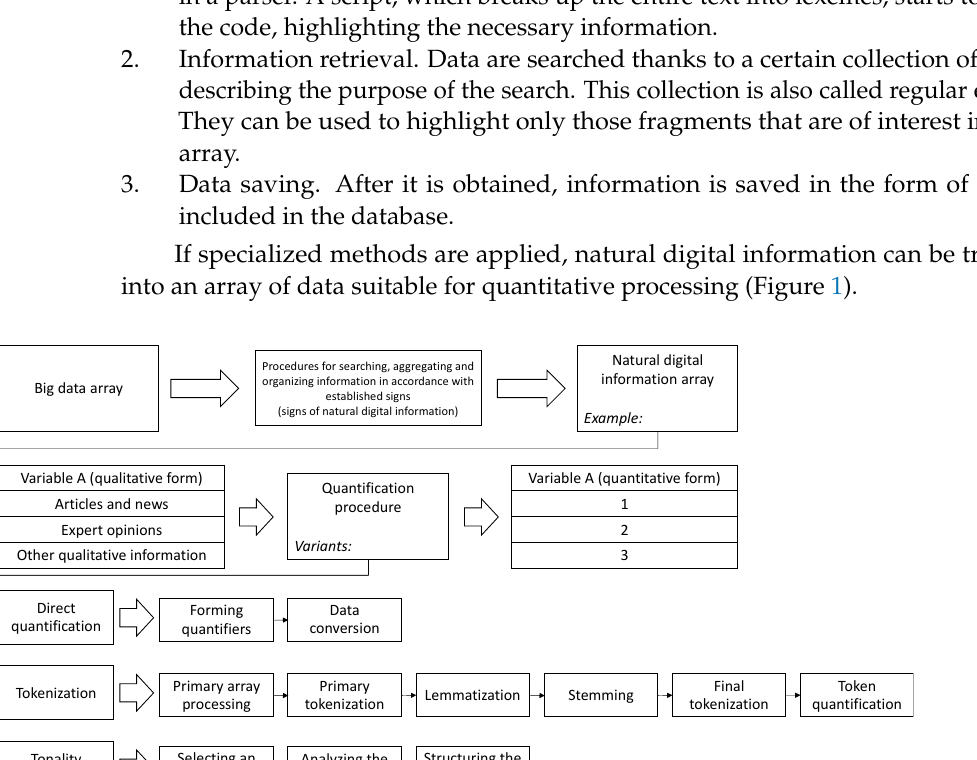
Figure 1. The process of processing of natural digital information.